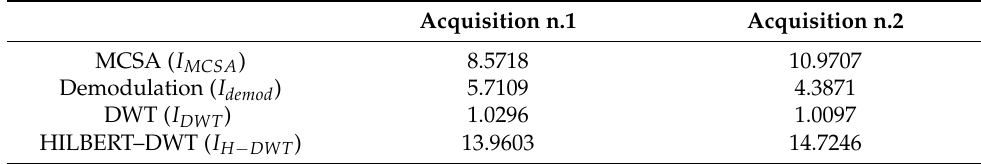
Table 6. Diagnostic indexes at constant speed—experimental